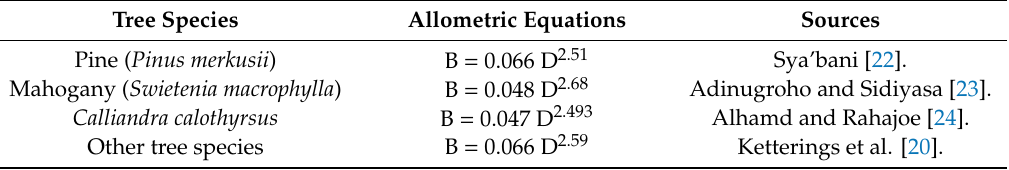
Table 1. Allometric equations used for converting the diameter at breast height into aboveground biomass. Tree Species Allometric Equations